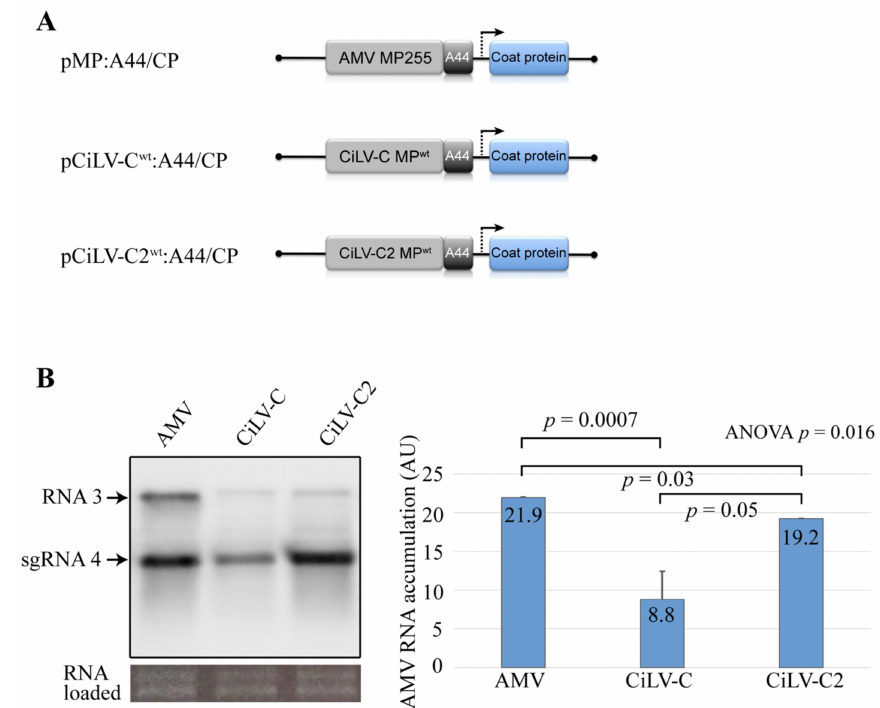
Figure 1. Northern blot analysis of the accumulation of alfalfa mosaic virus (AMV) RNA carrying citrus leprosis virus C (CiLV-C) and citrus leprosis virus C2 (CiLV-C2) movement proteins (MPs) in transgenic Nicotiana tabacum (P12) protoplasts. ( A ) The schematic representation shows the pAL3NcoP3 AMV RNA 3 construct [36] and its derivatives carrying the heterologous MPs fused to the C-terminal 44 residues of the AMV MP (A44), used in this assay. The open reading frames, represented by large boxes, correspond to the MP, and the coat protein (CP). The short box corresponds to the A44, meanwhile, arrow represents subgenomic promoter. ( B ) Northern blot showing accumulation of AMV RNAs in P12 protoplasts at 16 h post-inoculation, using a dig-riboprobe complementary to the 3 (cid:48) UTR of the AMV RNA 3. Transcripts correspond to the AMV RNA 3 derivative carrying the CiLV-C MP, CiLV-C2 MP, and AMV MP (positive control) proteins. The localization of RNA 3 and subgenomic RNAs (sgRNA 4) are indicated. The graph represents the total accumulation of AMV RNA, carrying the constructs AMV MP, CiLV-C MP, and CiLV-C2 MP from the average of two independent experiments. The bands were quantified using the ImageJ version 2.0cr software with the ISAC plugin and error bars represent standard deviation. Statistical analysis was performed using Student’s t -test and one-way ANOVA. p values less than 0.05 (typically ≤ 0.05) are statistically significant. p -values were obtained from pairwise comparisons between treatments or among the three